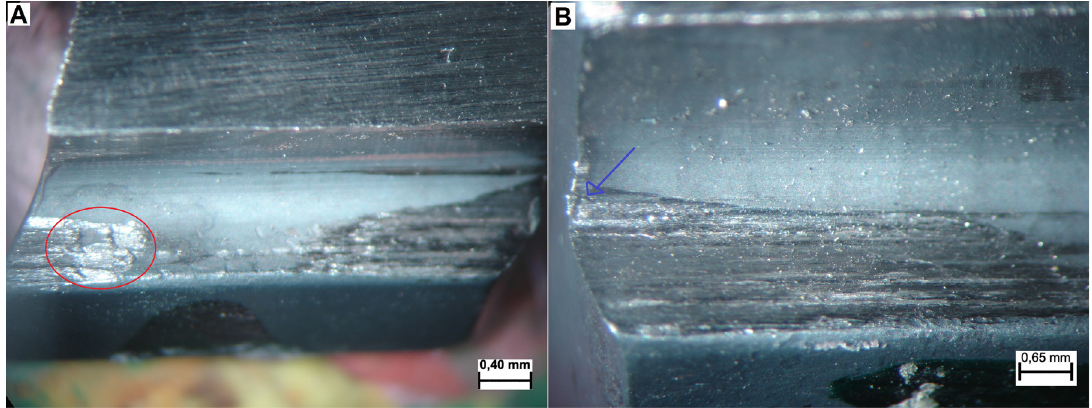
Figure 9. Stereographic images of the non-failed blade P1. (A) Showing shiny areas and plastically deformed material (red ellipse). (B) Plastic deformation at the origin of a crack at the edge between the curvature radius and the concave face of the blade (blue arrow).